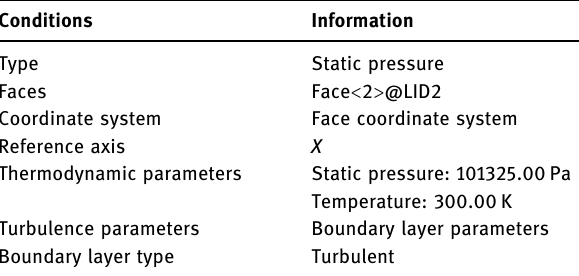
Table 4: Boundary conditions: static pressure